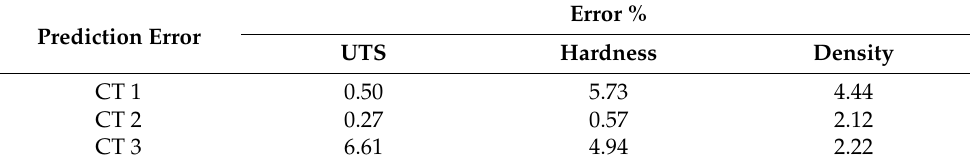
Table 10. RSM prediction